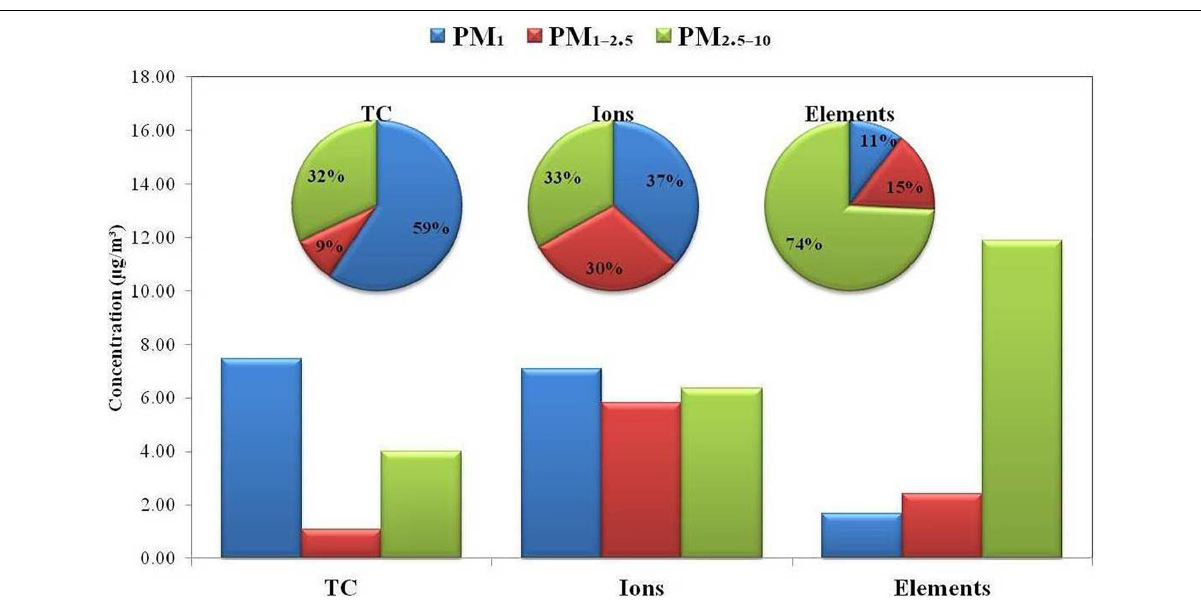
FIGURE 3 | Size distributions and contributions of the TC, ions, and